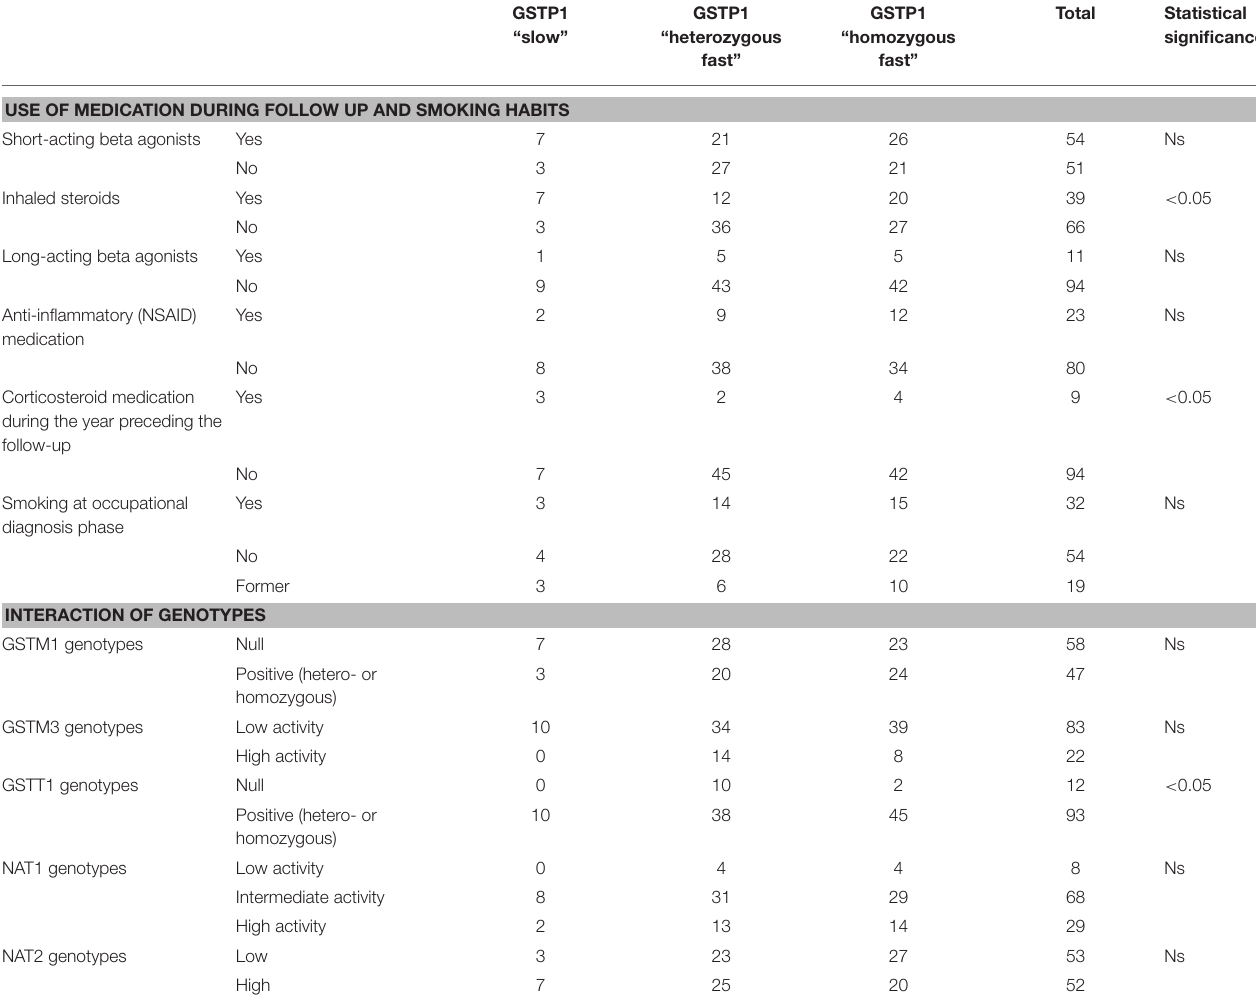
TABLE 5 | Potential interacting factors, smoking, and medications of patients with different GSTP1 genotypes during the follow-up and interaction between GSTP1 and other GST genes and NAT genes.